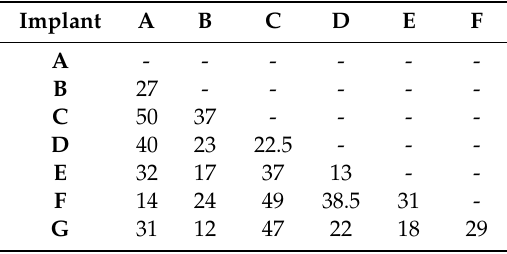
Table 3. The obtained values of the di ff erence factor f 1 .